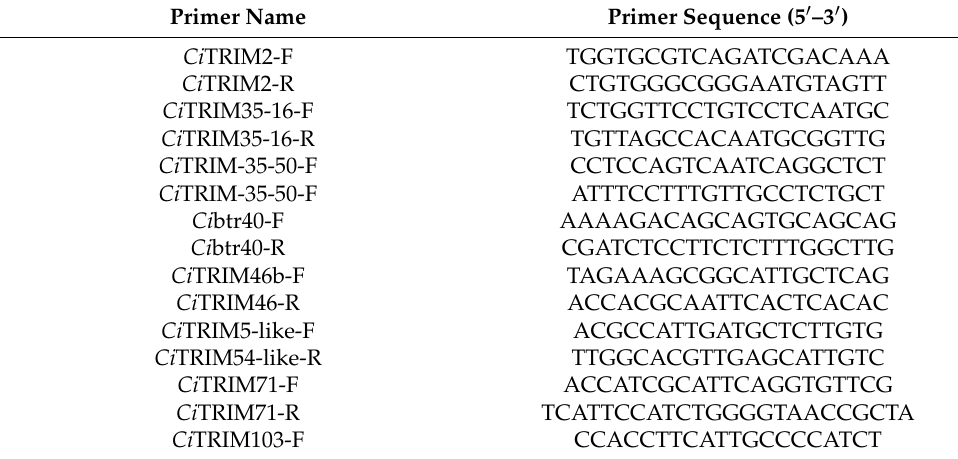
Table 1. The qPCR primers used in this